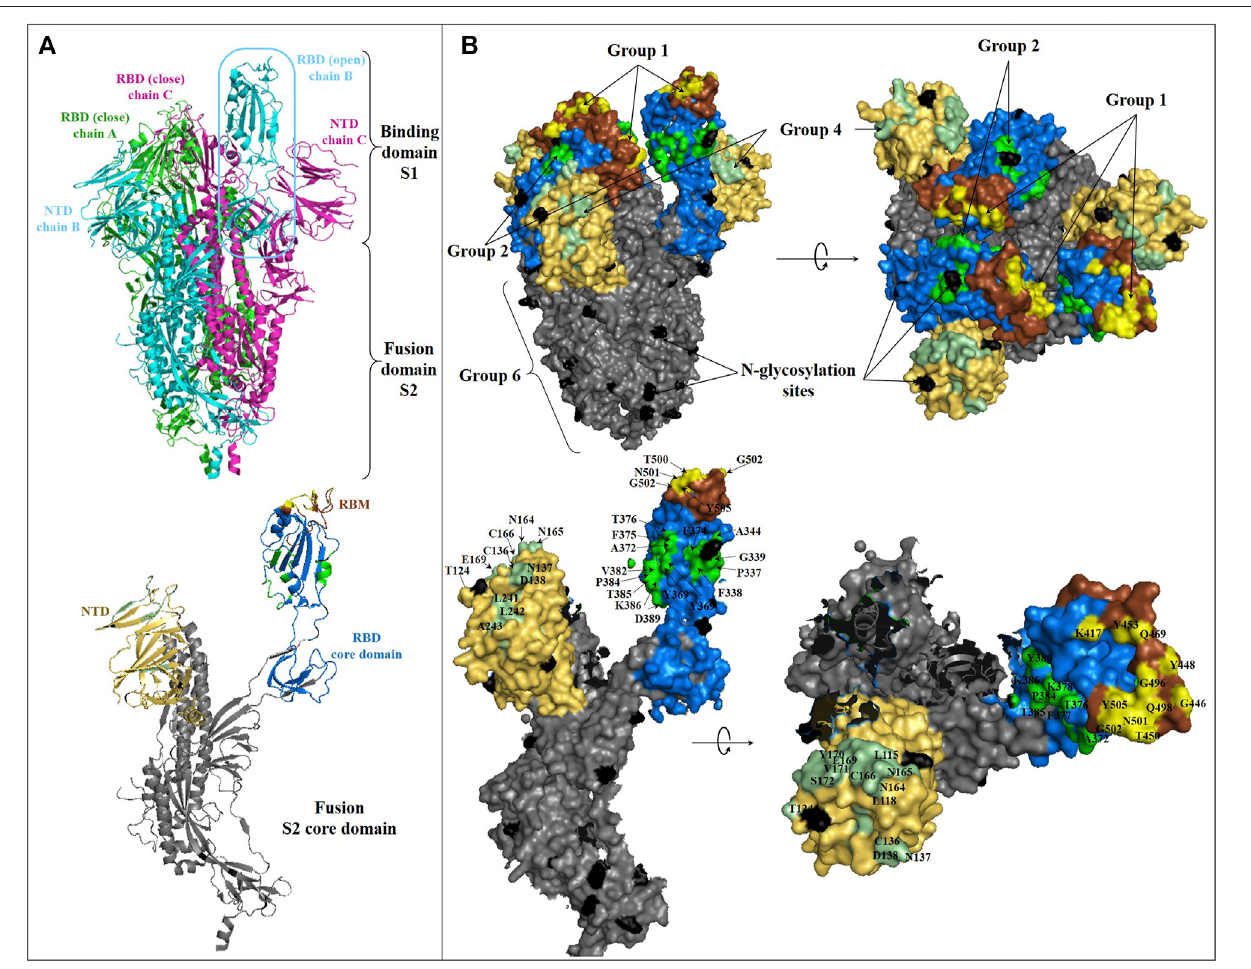
FIGURE 3 | Structure of SARS-CoV-2 spike glycoprotein and representation of the main antibody-targeted regions. (A) : Overall crystal structure in cartoon representationoftrimeric (top) andmonomeric (bottom) SARS-CoV-2SpikeproteinwithonechainBintheopenconformation(PDB:6VYB).TheNTD,RBD,RBM,and S2 domains in monomeric representation (bottom) are colored as in Figure 2B . (B) : Binding surface/interface of the described NmAb groups on SARS-CoV-2 S glycoprotein. The RBD core domain is colored in blue, as in Figure 2B . The competitive binding surface of hACE2 with most of the described RBM-speci fi c NmAbs, are colored in yellow [hACE2 binging epitope comprising K417, G446, Y449, Y453, L455, F456, A475, F486, N487, Y489, Q493, G496, Q498, T500, N501, G502,and Y505(Lanet al.,2020)].TheepitopesurfaceofNmAbsonRBDoutsideofRBMiscoloredingreen(based onS309(Pintoetal.,2020a),EY6A(ZhouD.et al., 2020), and CR3022 (Yuan M. et al., 2020) binding epitopes). Residues of surface S1 outside of RBD are not represented but are located within the RBD core domain coloredinblue. TheS2bindingsurface,including HR1and HR2,iscoloredindarkgrey.TheNTD-bindinginterfaceiscoloredinpalegreen(based